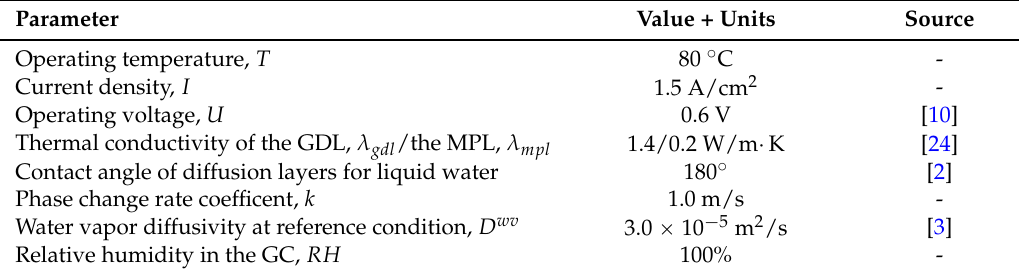
Table 2. Physical and operating parameters used in the base case, i.e. , case